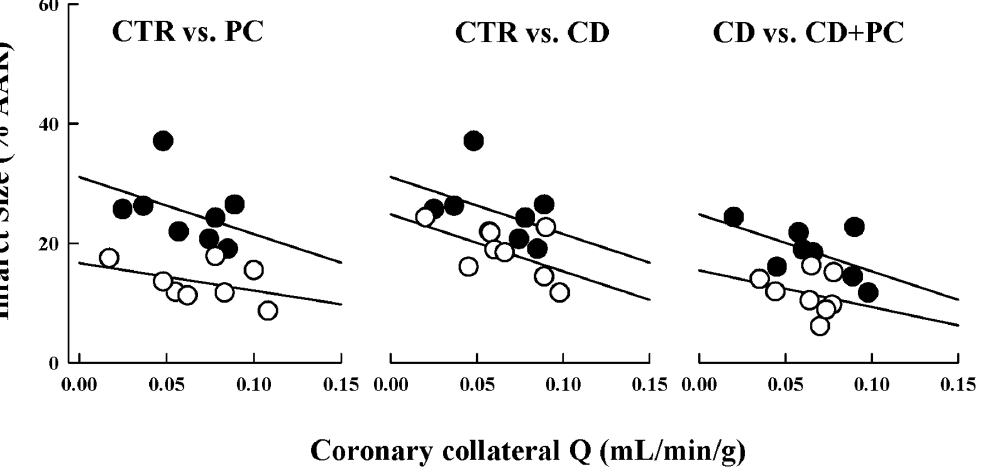
Figure 4. Infarct size (% AR) versus coronary collateral blood flow (mL/min/g). Left panel: CTR (closed symbols; y=32.4 2 112.6X, r 2 =0.203) versus PC (open symbols; y=11.6 2 32.9X, r 2 =0.055) dogs. Middle panel: CTR (closed symbols; y=32.4 2 112.6X, r 2 =0.203) versus CD (open symbols; y=24.9 2 96.4X, r 2 =0.327). Right panel: CD (closed symbols; y=24.9 2 96.4X, r 2 =0.327) versus CD + PC (open symbols; y=15.5 2 60.7X, r 2 =0.079) dogs. The downward shift of the regression indicates significant protection that occurs independently of changes in coronary collateral blood flow. Each point represents an individual dog.